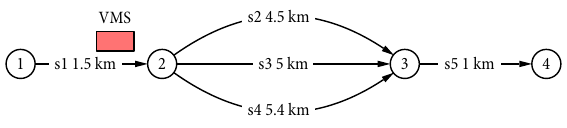
Fig. 7. Simulation road network